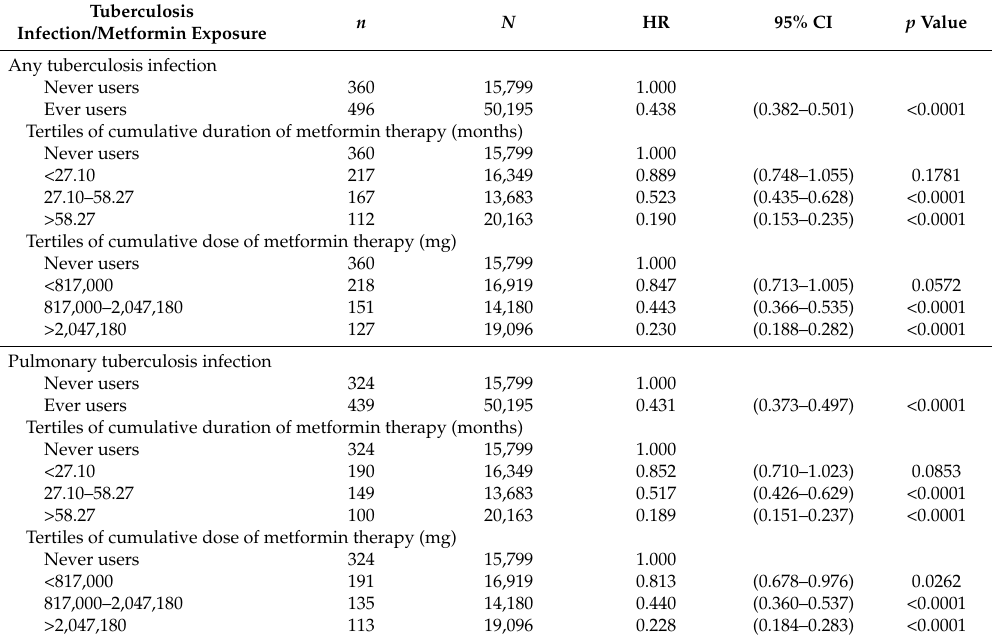
Table 3. Sensitivity analyses after excluding metformin irregular users who had two consecutive prescriptions spanning more than four